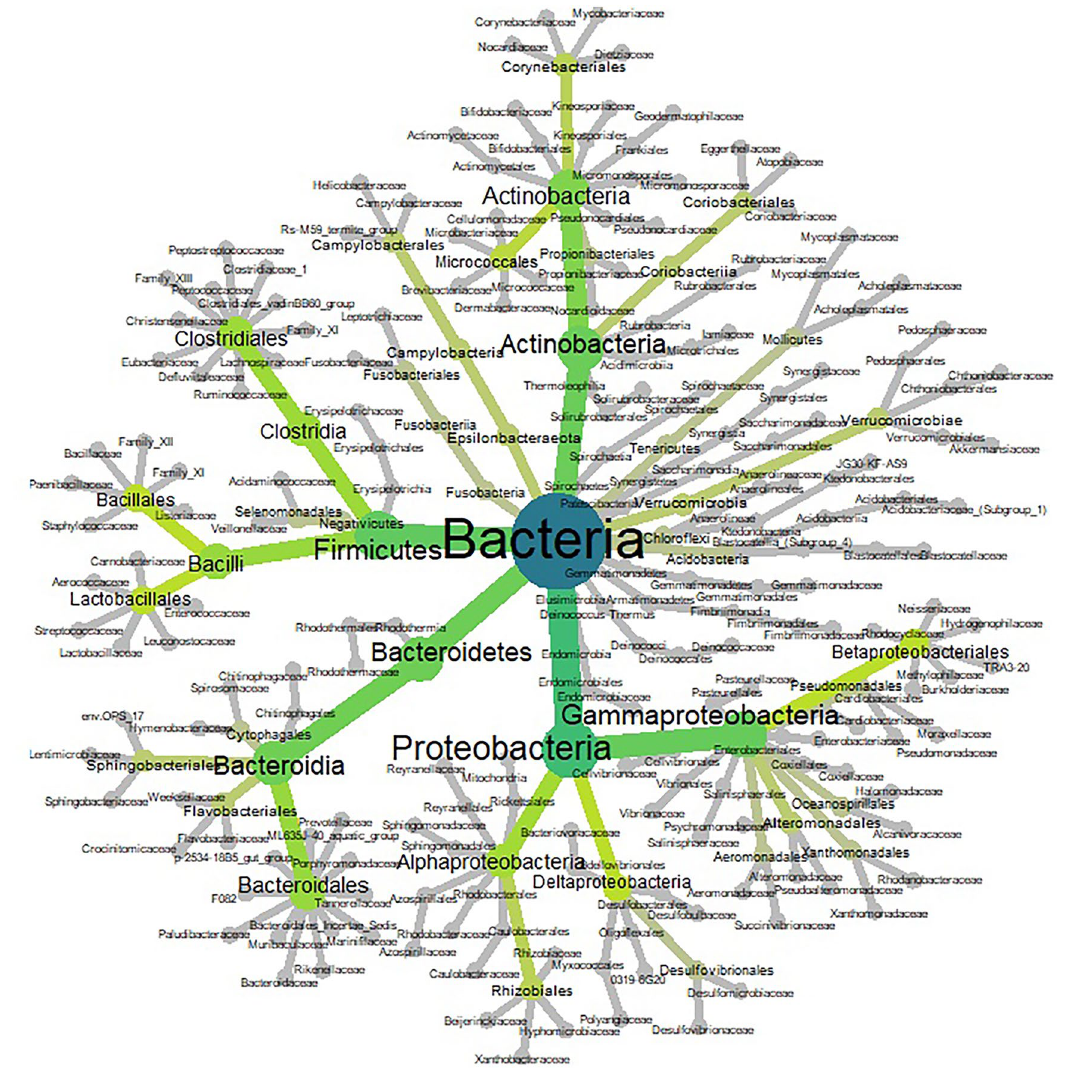
Figure 1. Heat tree of phylogenetic relationship and relative abundance of ASVs within the saliva microbiota of TwinsUK participants (n = 679). Colour and size of nodes relate to the taxonomic level and abundance of taxa, respectively. Higher to lower taxonomic levels range from blue to dark green to light green, to